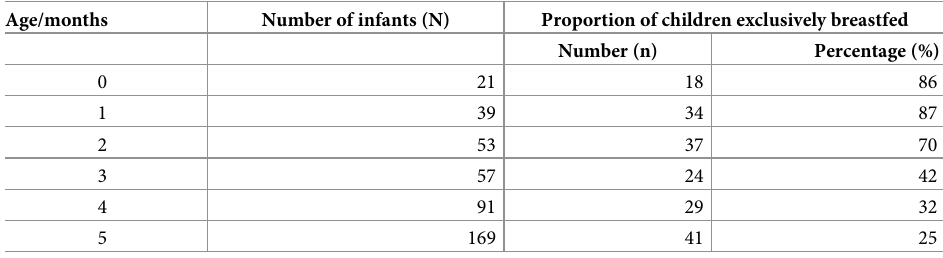
Table 3. Prevalence of exclusive breastfeeding by infant’s